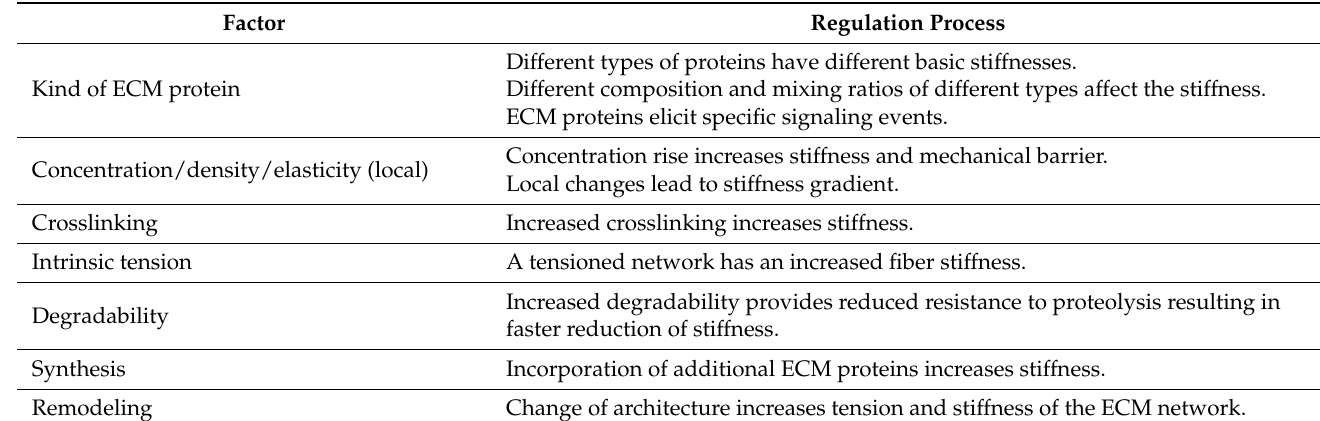
Table 1. Factors influencing ECM stiffness and their regulating processes. Factor Regulation Process Different types of proteins have different basic stiffnesses. Kind of ECM protein Different composition and mixing ratios of different types affect the stiffness. ECM proteins elicit specific signaling